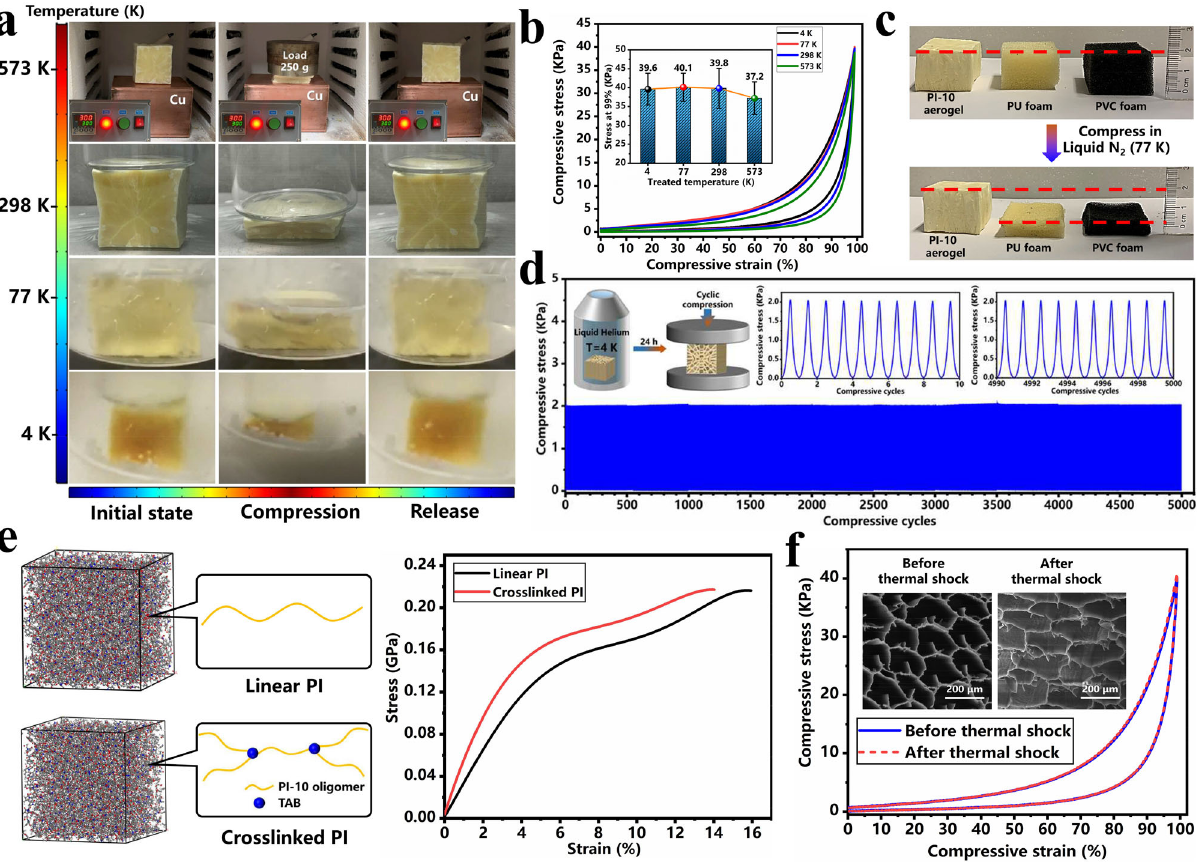
Fig. 5 Mechanical performance of PI aerogel in various environments. a Optical images of PI-10 aerogels during elastic tests at different temperatures from 4 K to 573 K. b Compressive stress-strain curves and compressive stress at 99% strain of PI-10 aerogels after being treated under different temperatures for 3 min. c Optical images of PI-10 aerogel, PU foam, and PVC foam before and after compression tests in liquid N 2 . d Fatigue test curves of PI-10 aerogels after being treated in liquid helium (4 K) for 24 h. e Models and stress-strain curves of linear PI and crosslinked PI by simulation of molecular dynamics. f Compressive stress-strain curves and SEM images of PI-10 aerogels before and after thermal shock